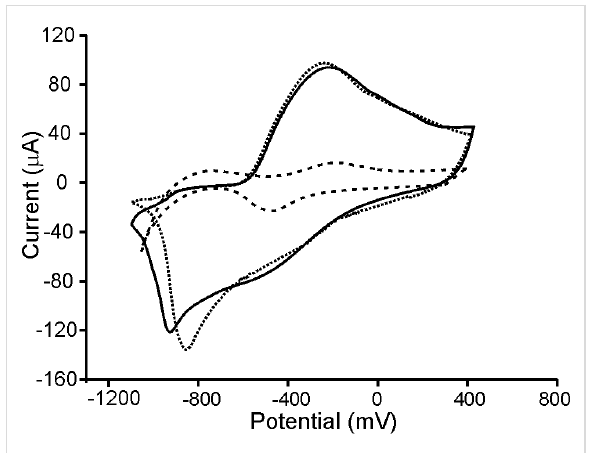
Figure 4: Cyclic voltammograms of Ppy-CP Pt (dashed line), Ppy/AuNPs-T-CP Pt (dotted line) and Ppy/AuNPs-C-CP Pt (solid line) immersed in 0.1 mol/L KCl. Scan rate 0.1